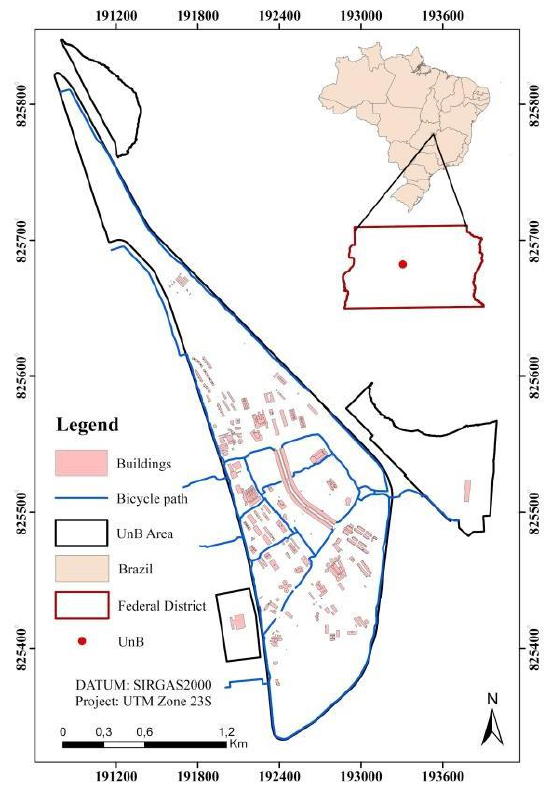
Figure 1: Map of the cycling network of the University of Brasília Source: The Authors The slope determination was made from a digital elevation model that was produced using a database of 1m interval level curves arranged in a vetorial format (SEDUH, 2019). For the generation of MDE the software used was the ArcMap from ESRI, version 10.6.1.